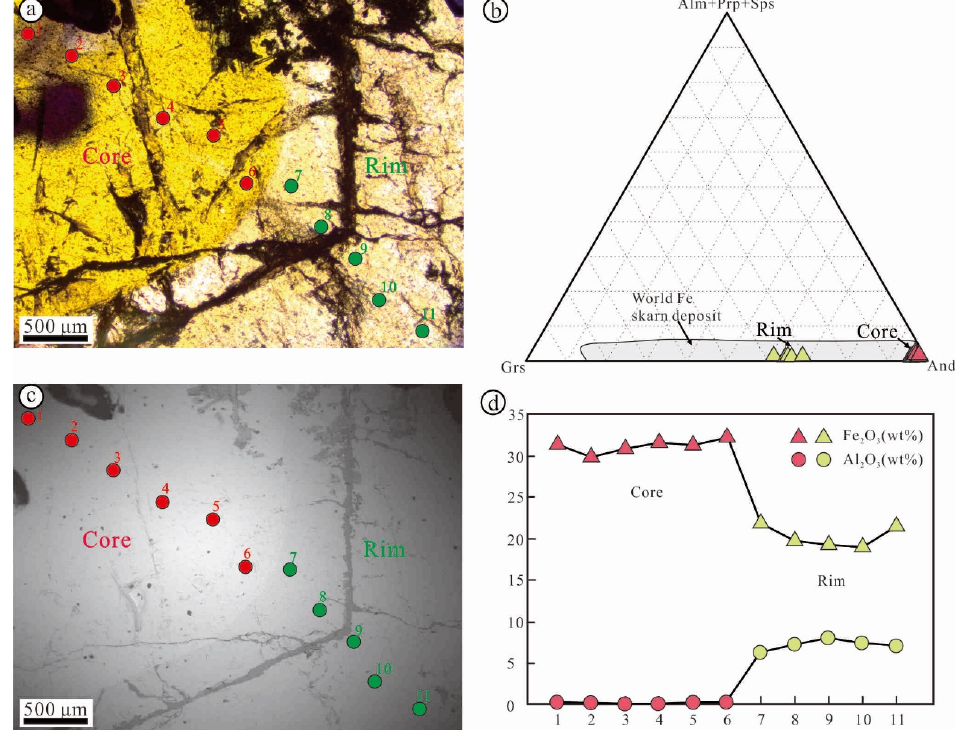
Figure 11. Photomicrographs were taken under open polarizer ( a ), BSE image ( c ) and compositional variation ( b , d ) of garnets from Jinling skarn and ore and the compositional fields for garnet in Fe skarn deposits (Meinert et al. [25]) are shown in the diagram for